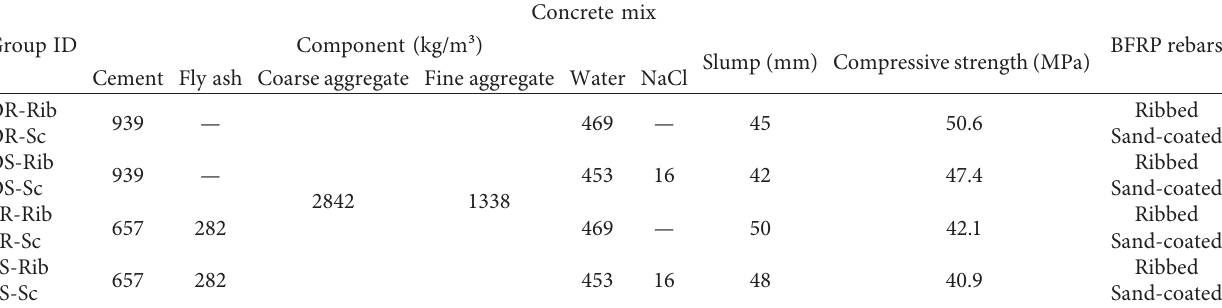
Table 2: Details of pullout testing groups and concrete mix